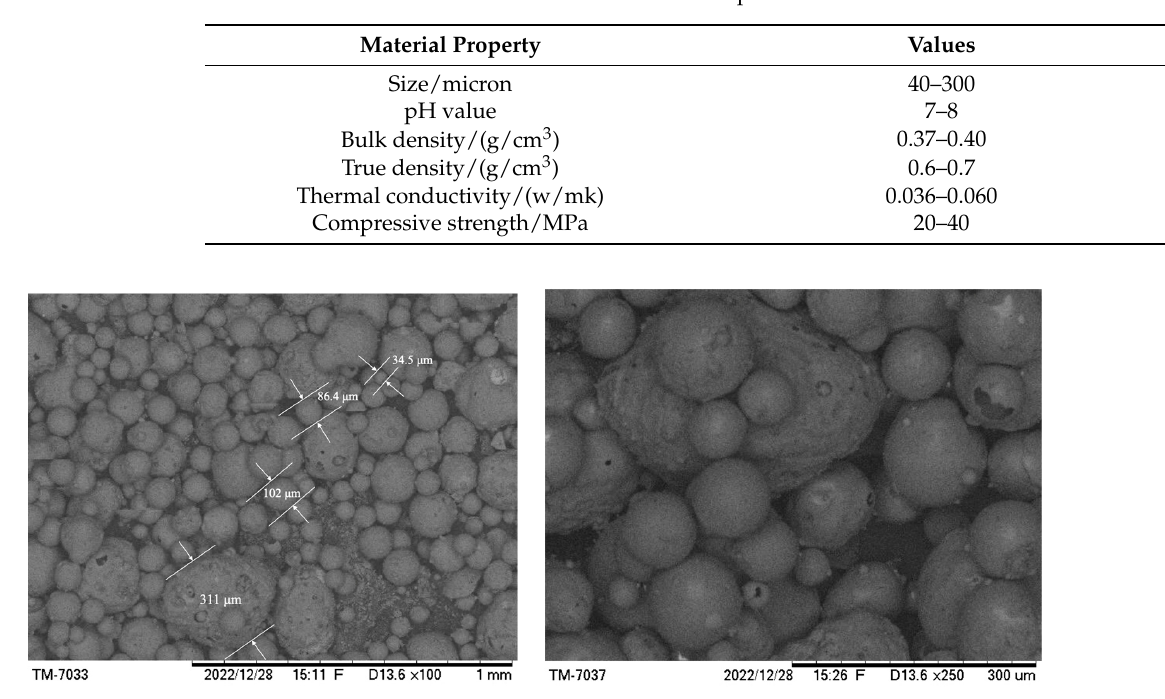
Figure 1. Microstructure of FAC.